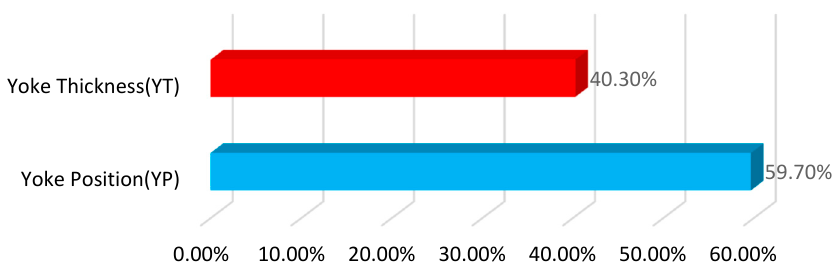
Figure 20. Analysis results of sensitivity by performance factor of magnetic thickness minimization. The probability distribution of the design parameters is a normal distribution that averages the standard deviations calculated using Equations (13)–(16), and the median values of the upper and lower limits of the nominal dimension, as defined in Figure 21. The mean and standard deviation of each design parameter are listed in Table